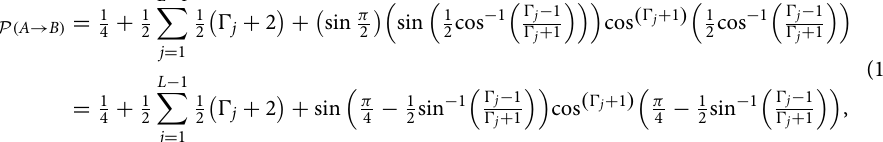
Figure 3. The values of ζ E the same value for all k , k Ŵ j 6 ( h ) Ŵ j =